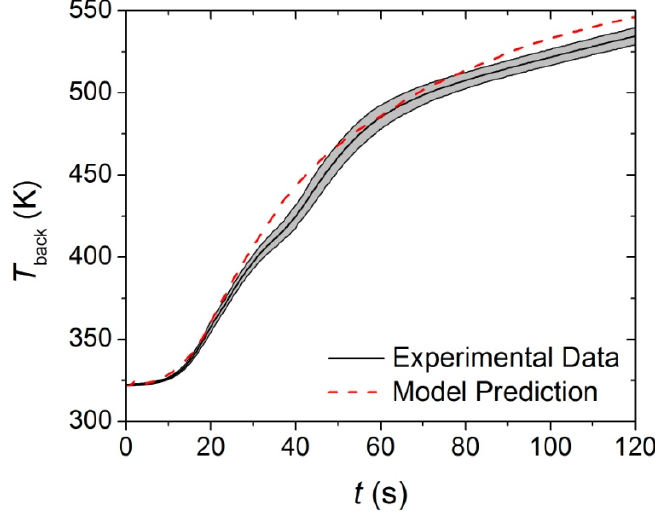
Figure 11. First 120 s of experimental T back curve measured in Controlled Atmosphere Pyrolysis Apparatus (CAPA) tests and corresponding model predicted curve for the upper layer exposed to a radiant flux of 30 kW·m − 2 . The shaded region corresponds to two standard deviations of the mean experimental data.